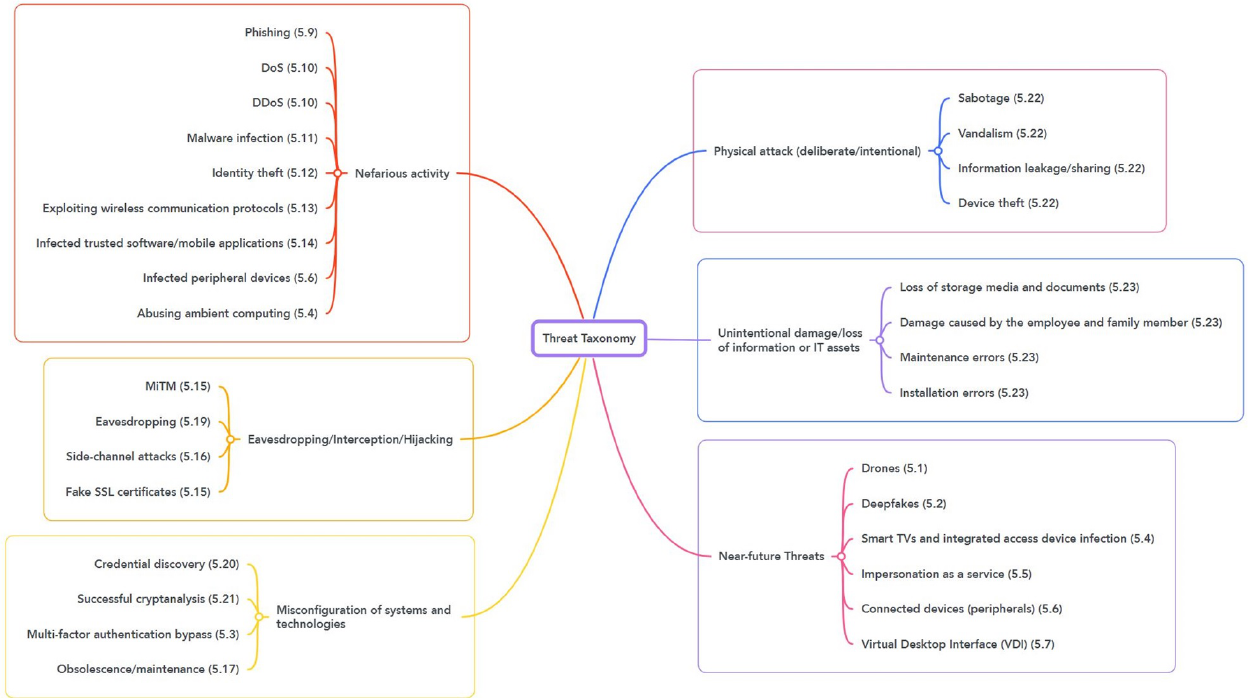
Figure 2. Threat